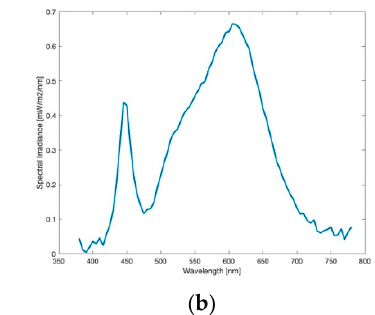
Figure 2. ( a ) Image of HPS lamp during night-time taken with fisheye lens for detailed analysis (date: 10.10.2018, 23:54 h; exposure time: 0.2 s); ( b ) Luminance matrix of image (a) as displayed by Sky Quality Camera (SQC); ( c ) Colour correlated temperature (CCT) matrix of image (a) as displayed by SQC.